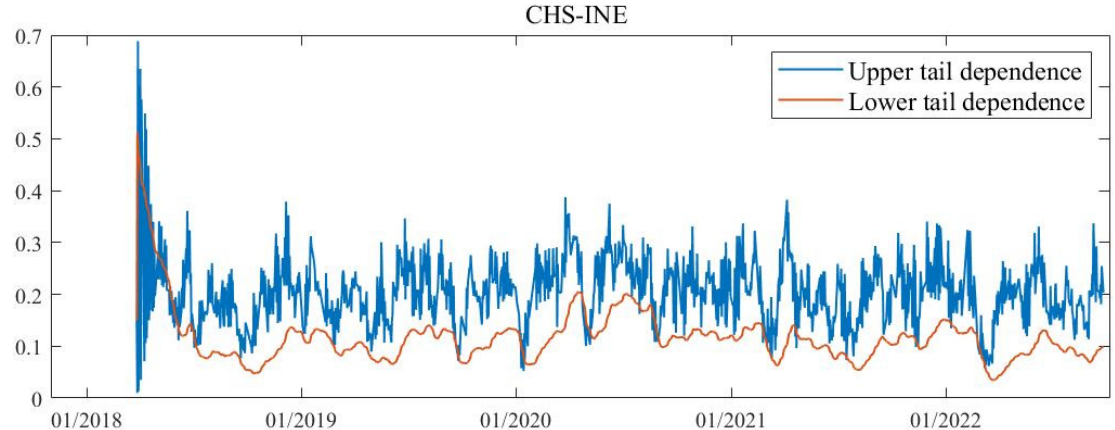
Figure 2. Time-varying tail dependences between Chinese stock and its domestic INE crude oil fu- tures.